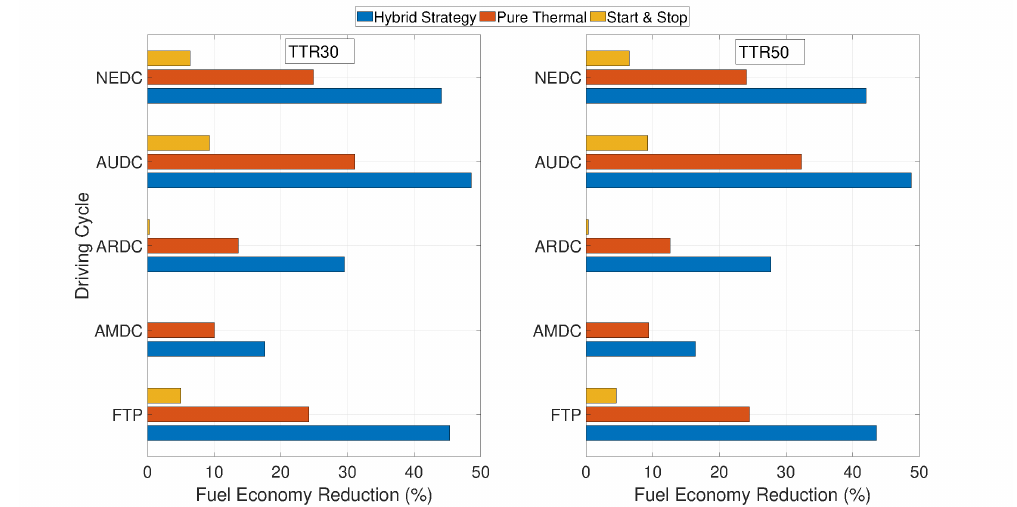
Figure 9. Fuel economy reduction with respect to the conventional vehicle, obtained with TTR30 and TTR50 vehicles for different driving cycles